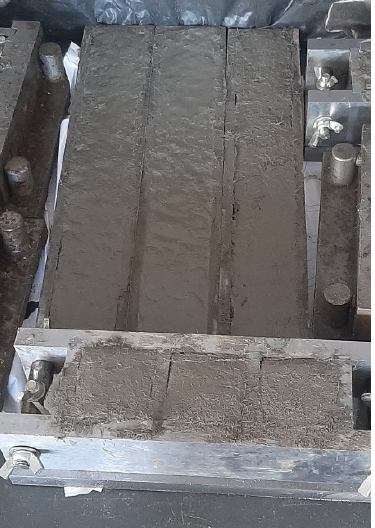
Figure 2. Poured fresh nanocalcite-doped ECC samples. Table 1. Chemical properties of binder and filler materials (% by weight).